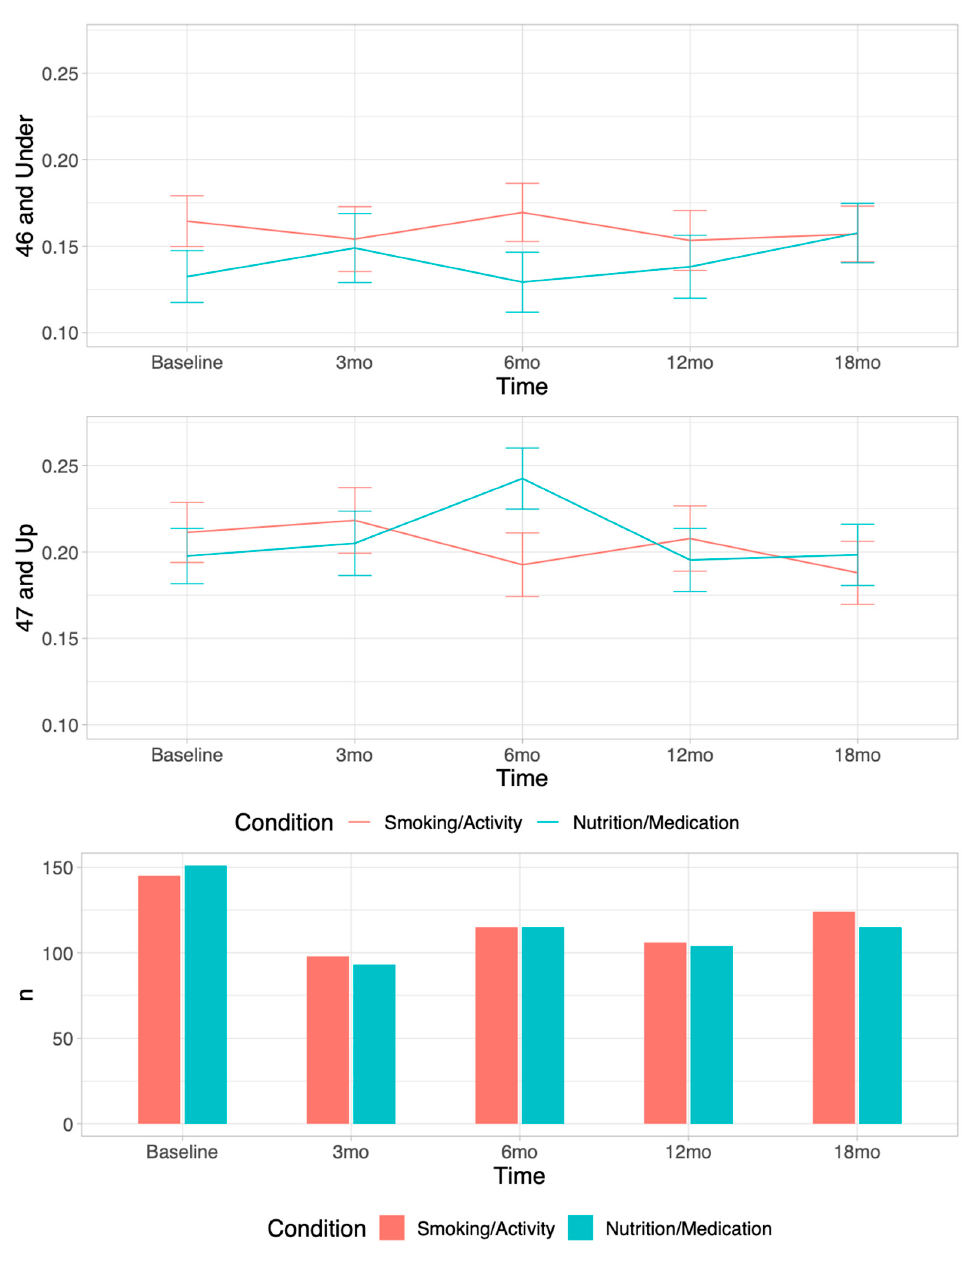
Figure 3. Traditional heart-healthy foods ratio by condition at each time point by median age split at 47 years. Means and standard deviations for the ratio of traditional heart-healthy food servings reported/total servings of foods reported are depicted for each condition at each time point; graphs split on median age of 47 years.